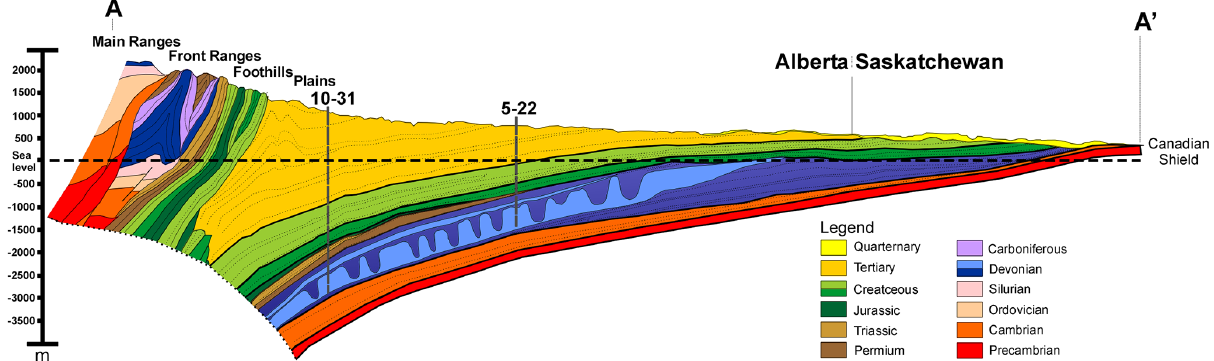
Figure 2. Schematic W–E cross section of the Alberta Basin (modified and simplified from Price, 1994). Line A–A (cid:48) is shown in the inset in Fig. 1.